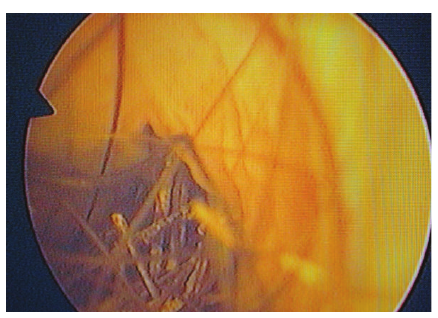
Figure 5: Case 2: initial urethroscopic